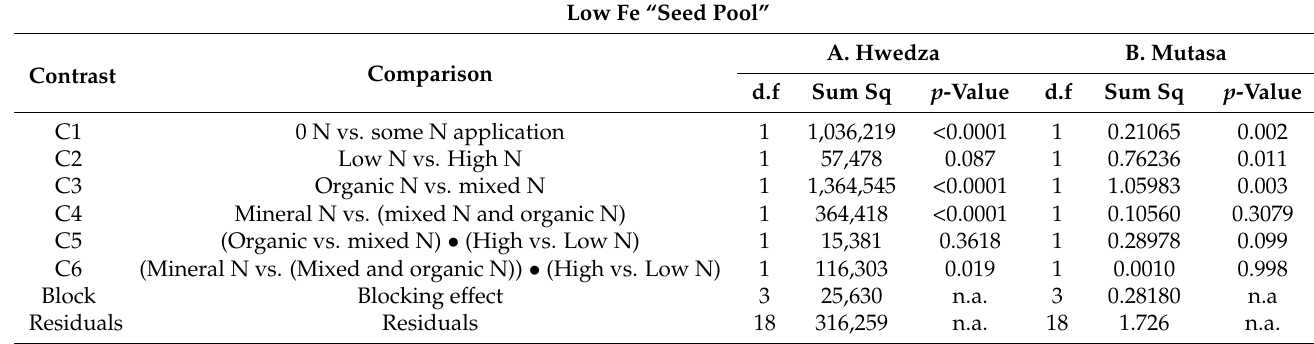
Table 9. ANOVA of contrasts showing effect of N management strategy on grain yields of the low Fe finger millet “seed pool” in Hwedza and